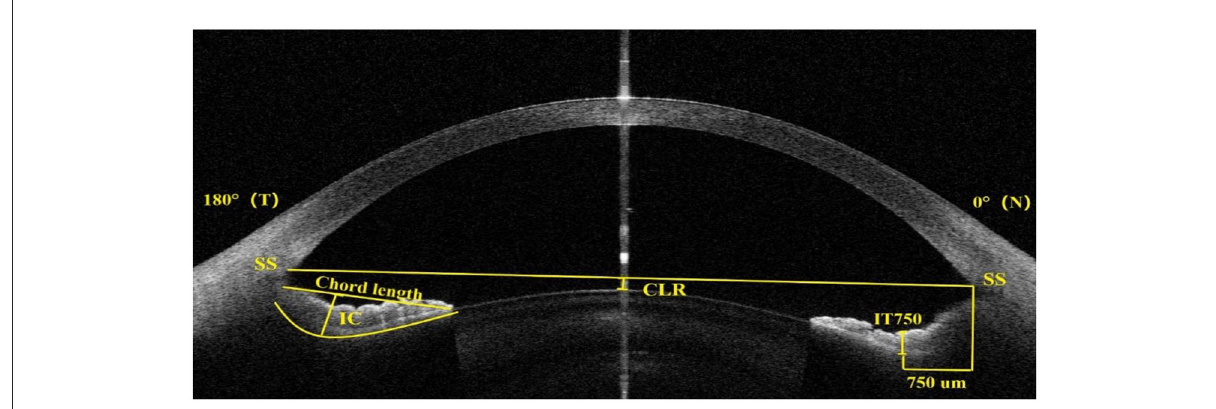
FIGURE1 Anterior segment optical coherence tomography image showing the measurement of the crystalline lens rise (CLR), iris concavity (IC), the ratio of the iris concavity to chord length (ICR), iris thickness at 750 µ m from the scleral spur (IT750) and scleral spur